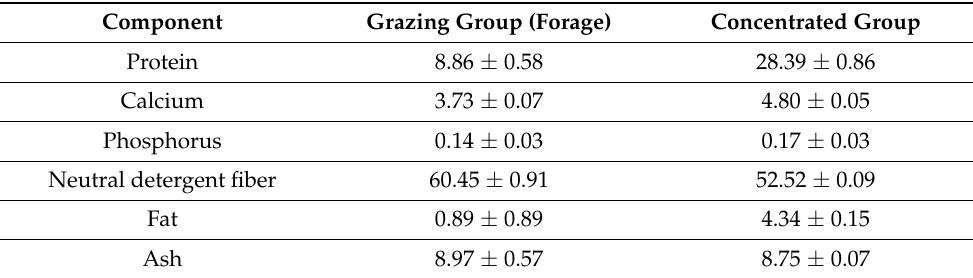
Table 1. Ingredients and nutrient composition of the diets during the